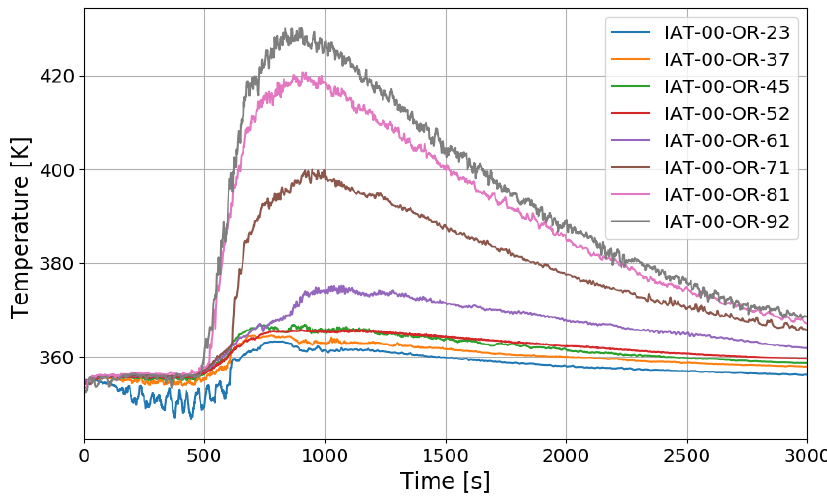
Figure 10. Temperature distributions along a center line for SP1 test.